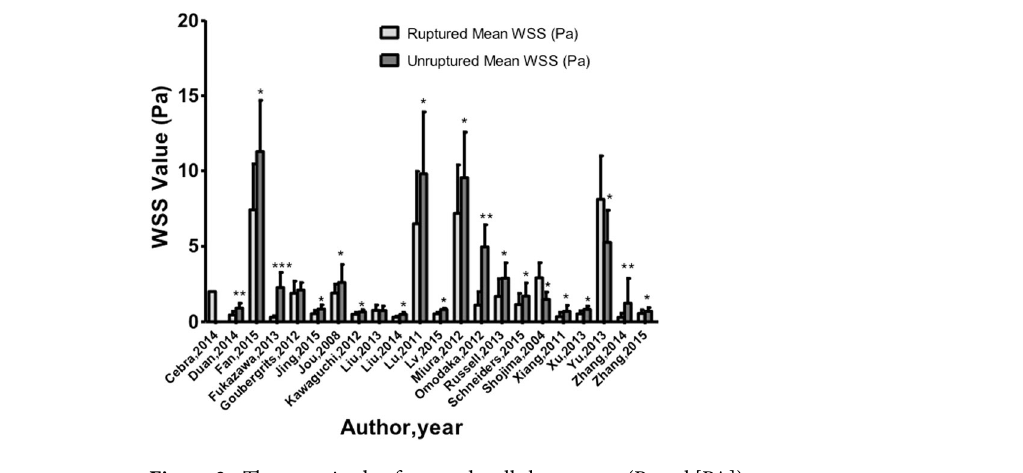
Figure 3. The magnitude of repoted wall shear stress (Pascal